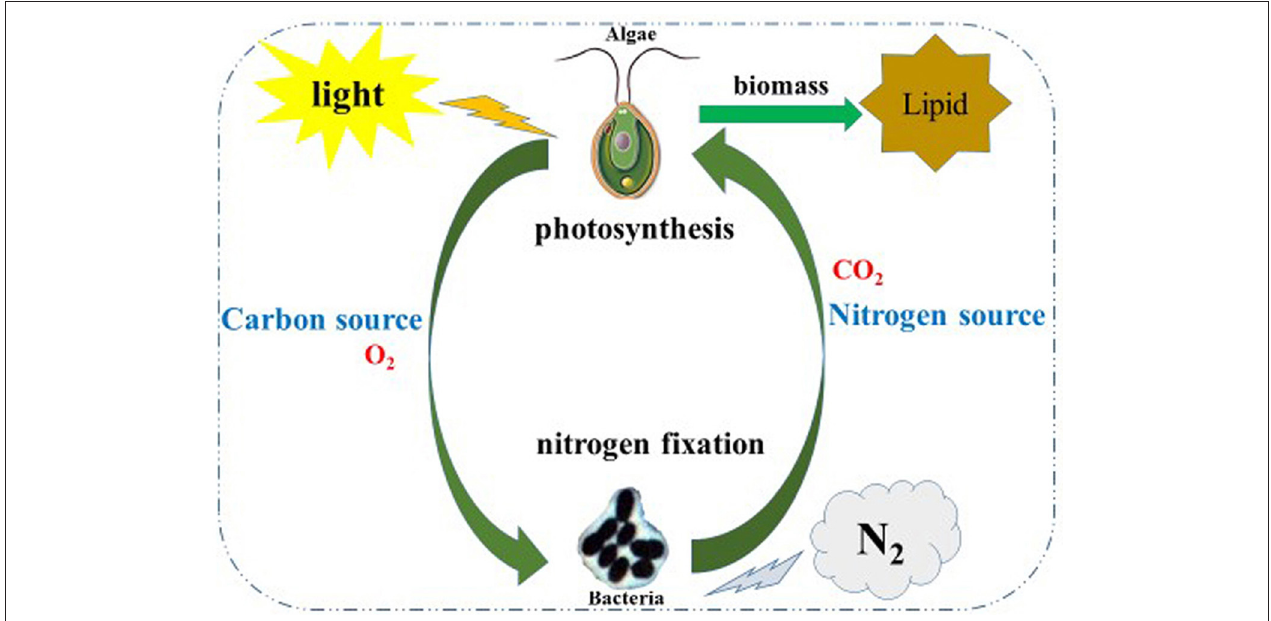
FIGURE 4 | Schematic illustration of the co-cultivation of the algae-bacterial system to improve biomass of and lipid production by algae. In this co-system, algae and bacteria could enhance the growth and biomass of each other through material exchange; algae supply carbohydrates and O 2 by photosynthesis meanwhile A. chroococcum supply the nitrogen source and CO 2 to algae by nitrogen fixation.